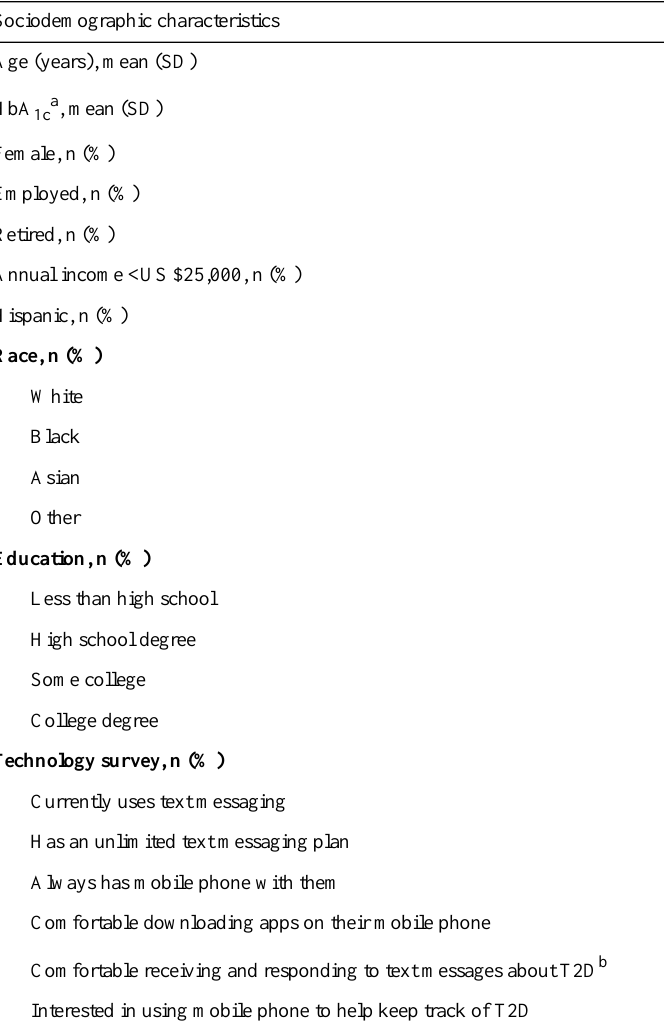
Table 3. Sociodemographic characteristics and comfort with technology survey responses among focus group participants